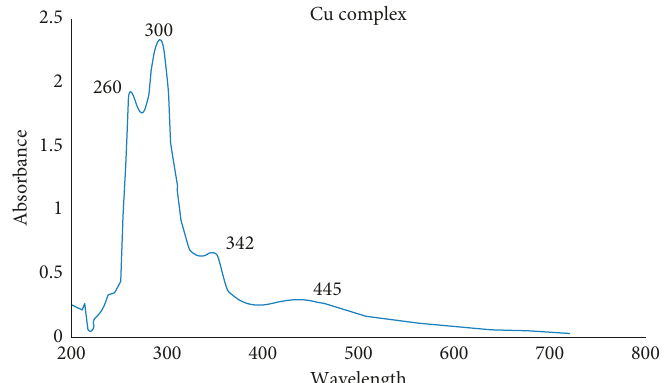
Figure 9: UV-visible spectrum of Cu(II) complex.